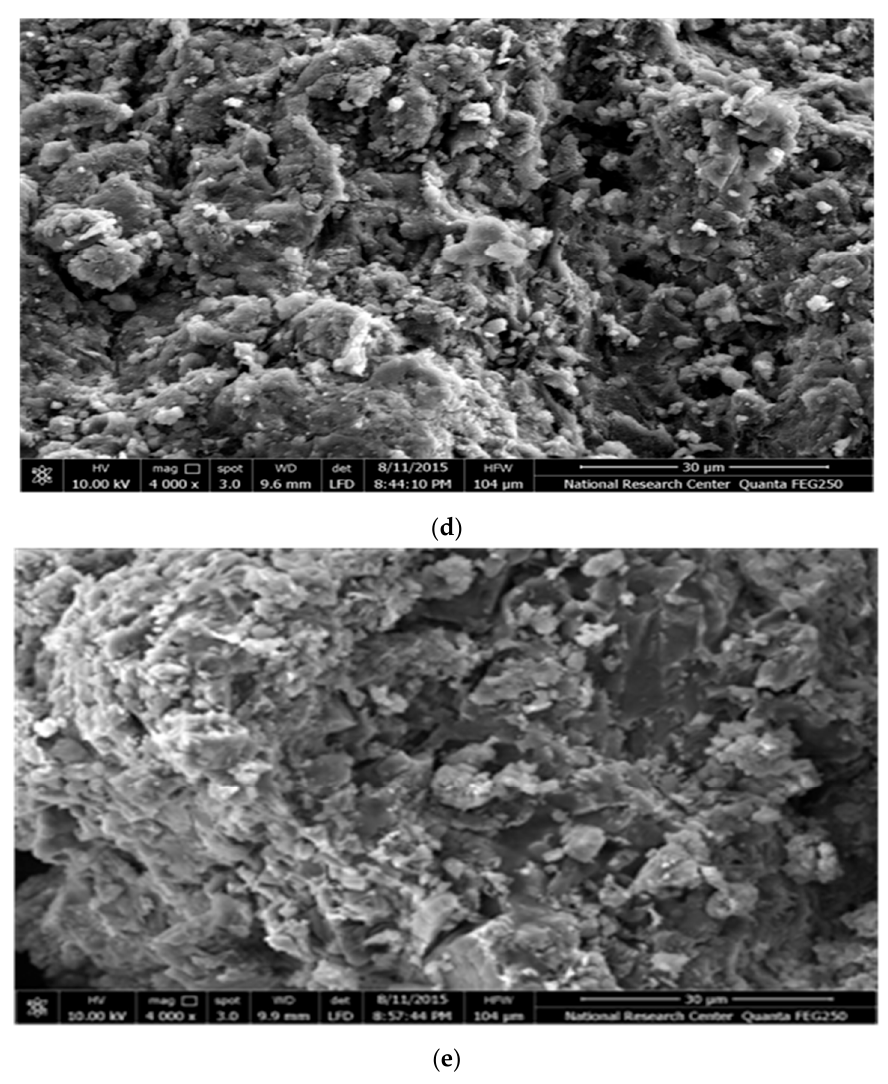
Figure 6. Scanning electron microscope of: fenoprofen calcium dihydrate ( a ); TA- β -CD ( b ); drug-TA- β -CD complex 1:3 ( c ); HPMC/drug complex ( d ); EC/drug complex ( e ).